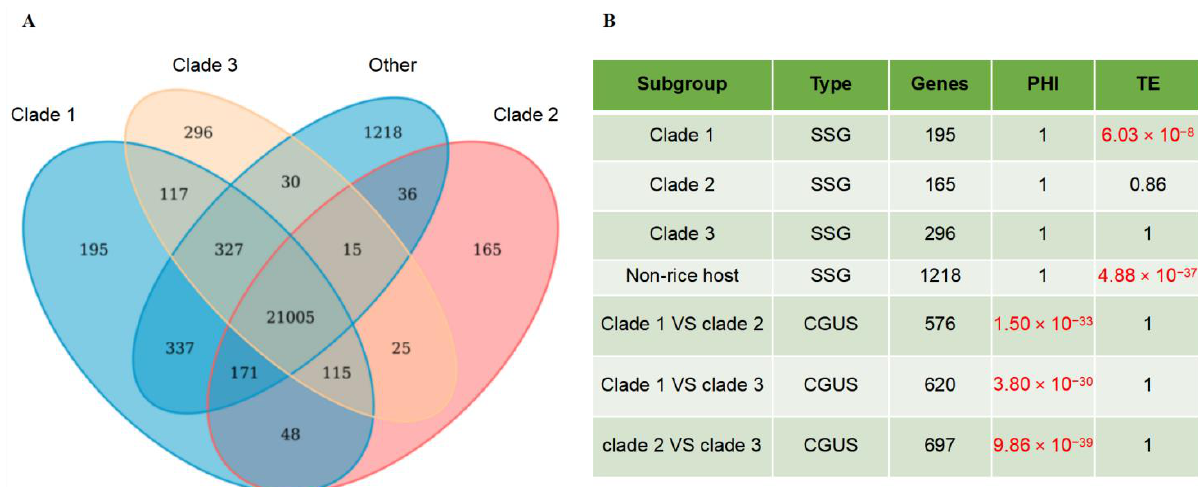
Figure 4. Population differentiation related genes in the pan-genome. ( A ) Comparison of the differ- ences between different subgroups. ( B ) Functional enrichment analysis of population differentiation related genes. SSG: Subgroup Specific Genes; CGUS: Core Genes Under Selection. Table 1. The KEGG pathway enrichment analysis of SSGs in rice-infecting strains (Top3).